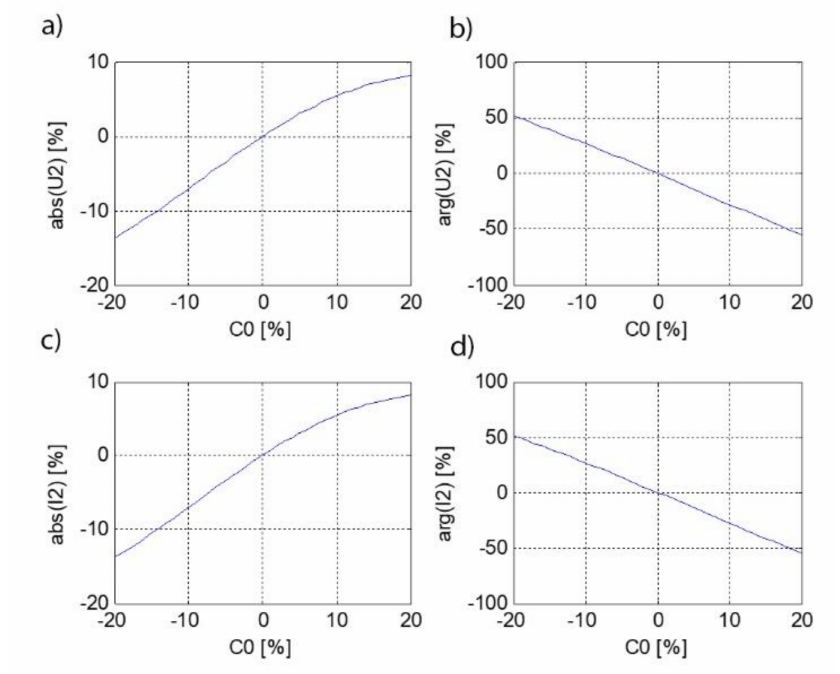
Figure 21. Changes of wave parameters depending on L 0 at f = 500 kHz; ( a ) U 2 voltage modulus, ( b ) U 2 argument, ( c ) I 2 modulus, ( d ) I 2 argument.